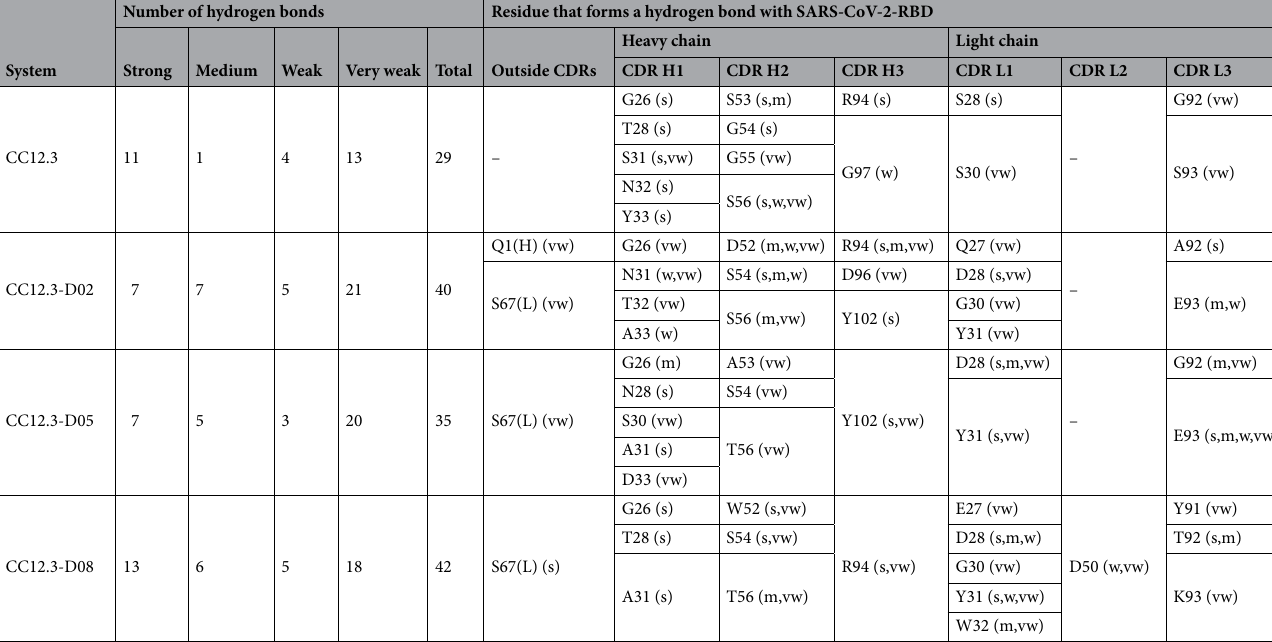
Table 3. Numbers of hydrogen bonds of CC12.3, CC12.3-D02, CC12.3-D05, and CC12.3-D08 involved in SARS-CoV-2-RBD binding. s strong hydrogen bond, m medium hydrogen bond, w weak hydrogen bond, and vw very weak hydrogen bond.